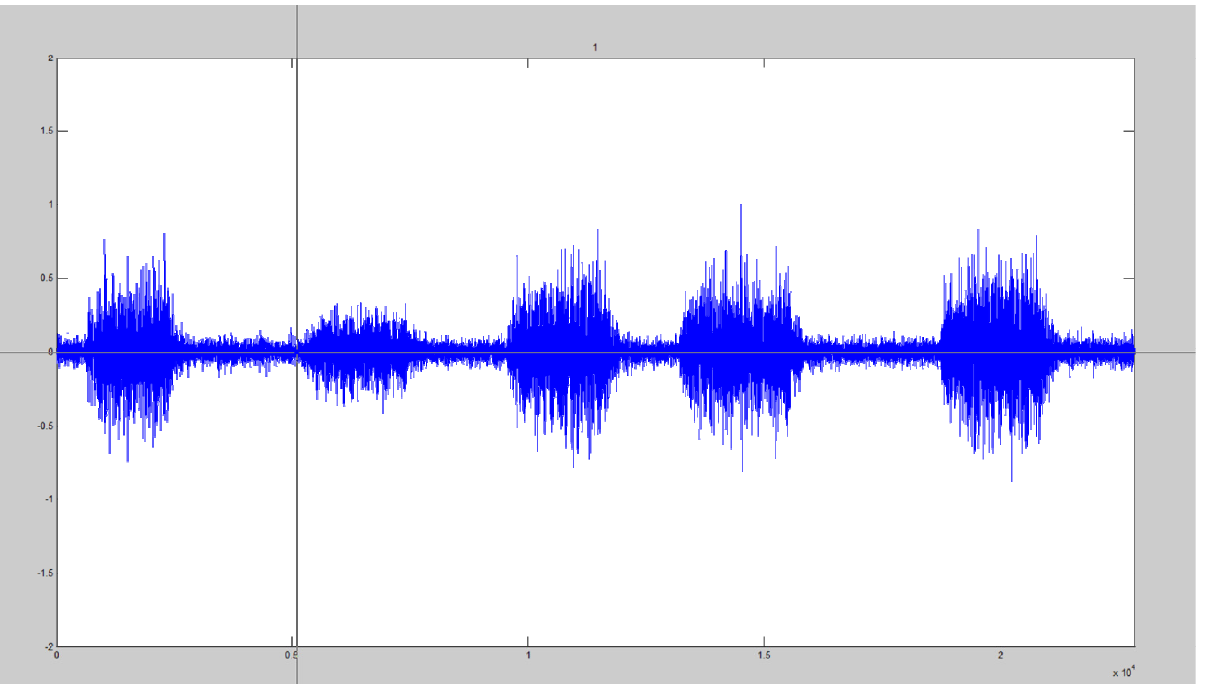
Figure 2. Visual detection GUI with the cursor displayed which allowed participants to select the onset location of five bursts of SIM EMG signals.